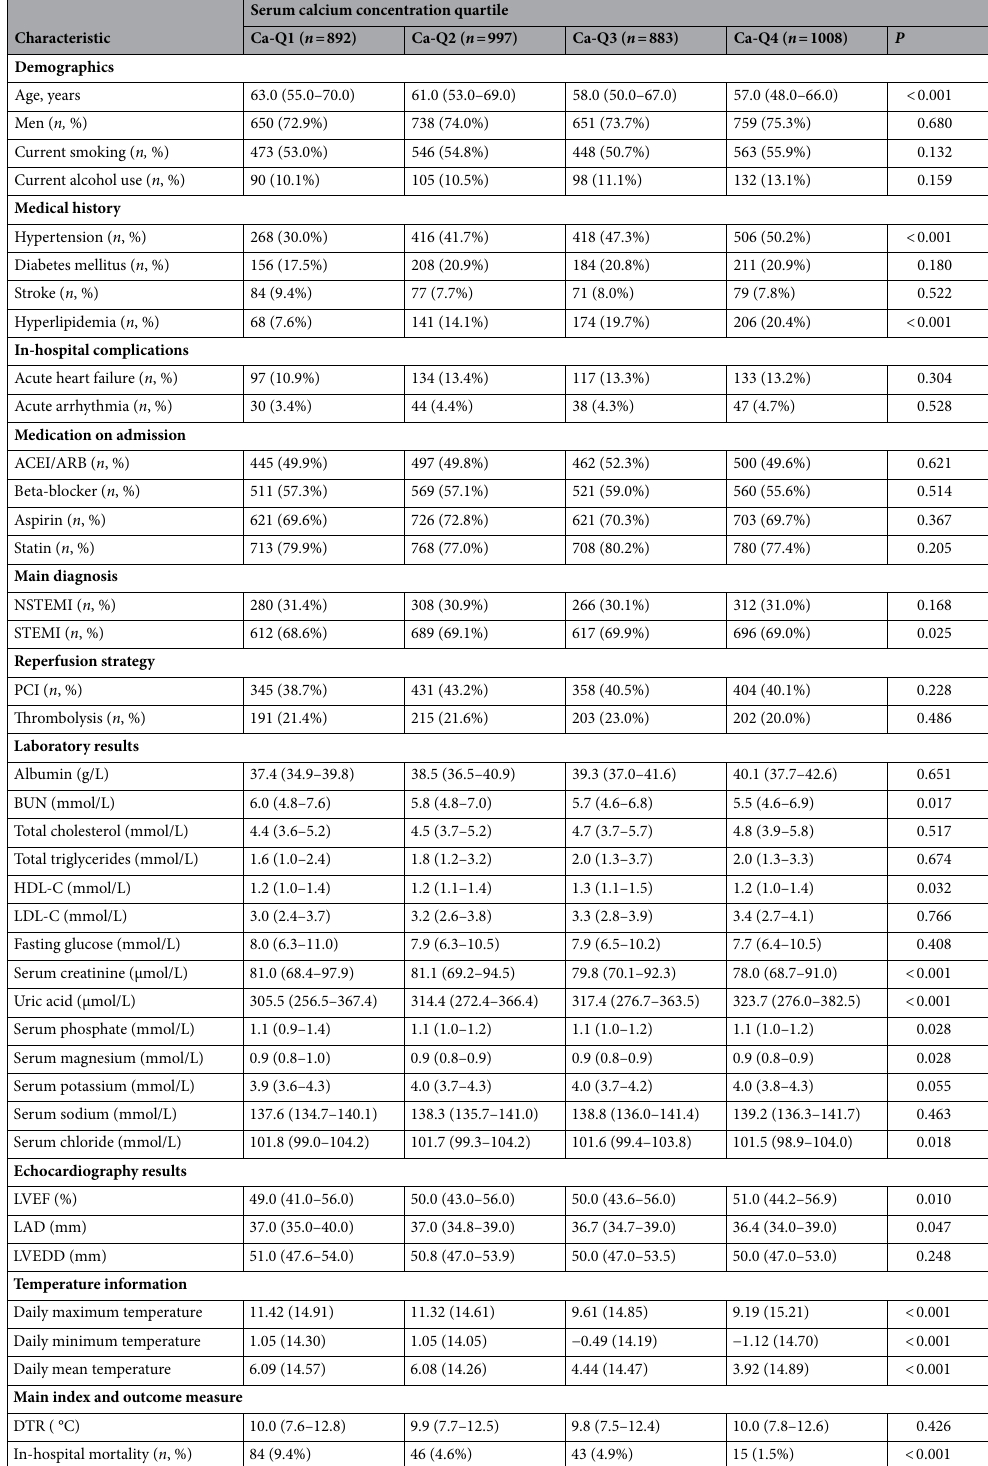
Table 1. Clinical characteristics of the 3780 patients with acute myocardial infarction stratified according to serum calcium concentration quartiles. Data are expressed as median (interquartile range) or n (%).